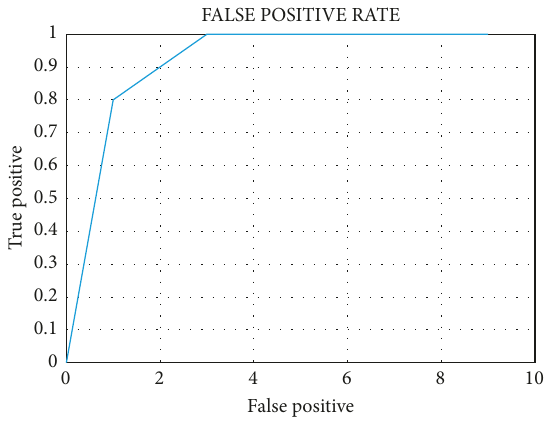
Figure 6: ROC for the proposed